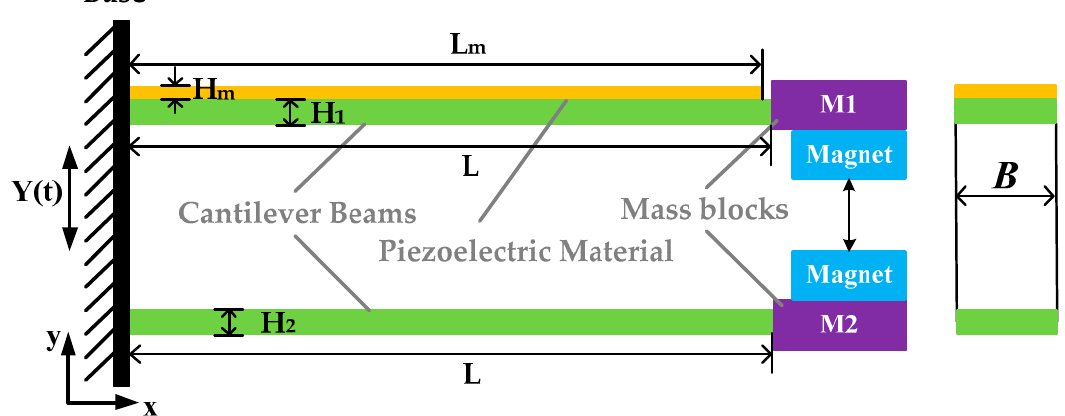
Figure 2. Schematic diagram of the magnetic coupled piezoelectric energy harvester.